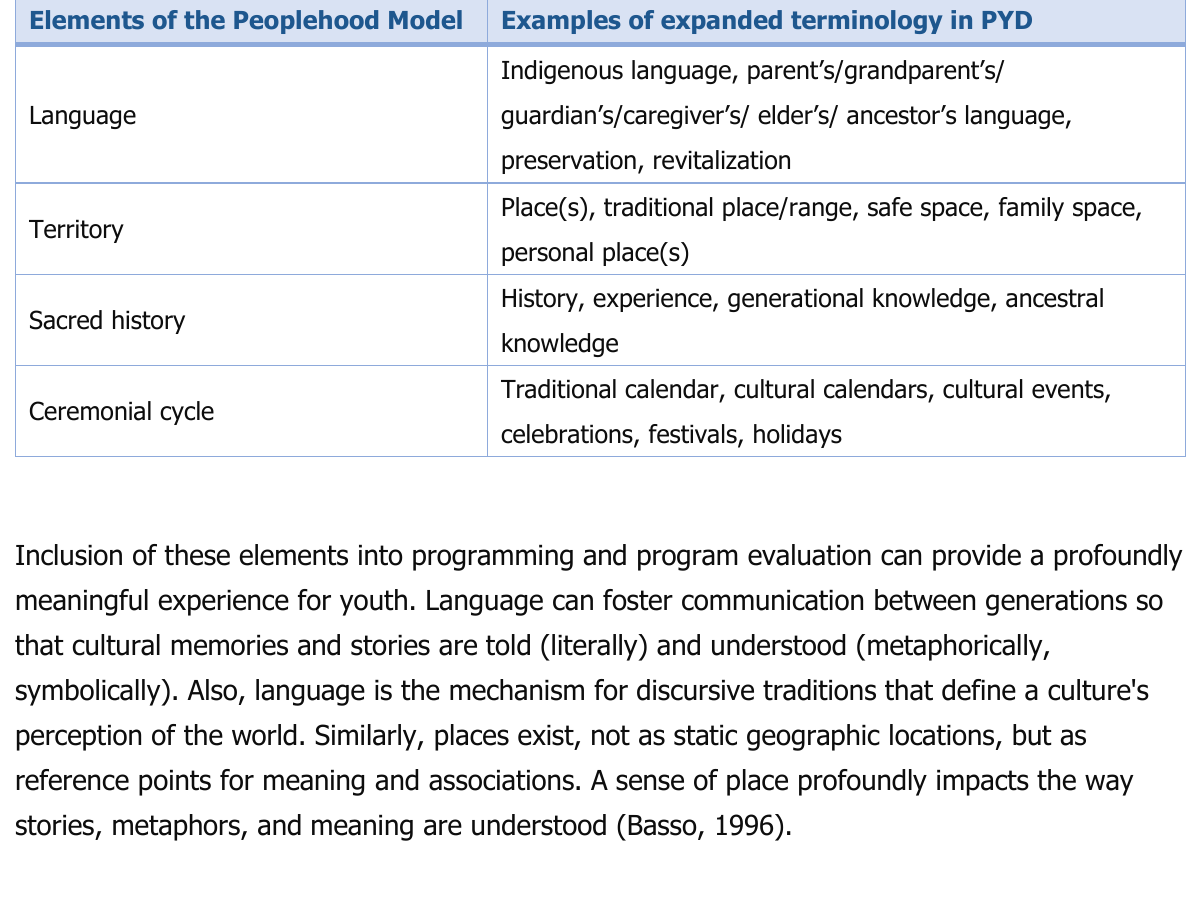
Table 1. Expanded Terminology for Applying the Peoplehood Model Elements in PYD Elements of the Peoplehood